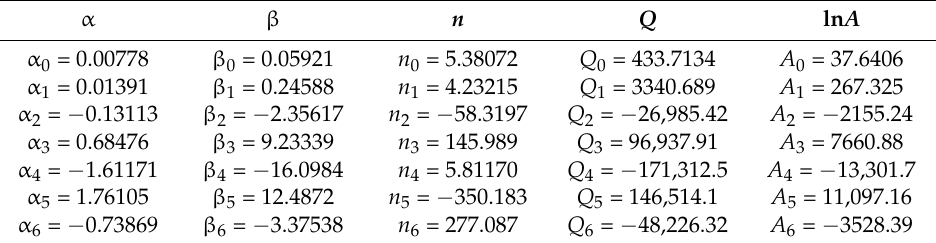
Table 2. Coefficients of the polynomial for α , β , n , Q , and ln A for 2707 HDSS.